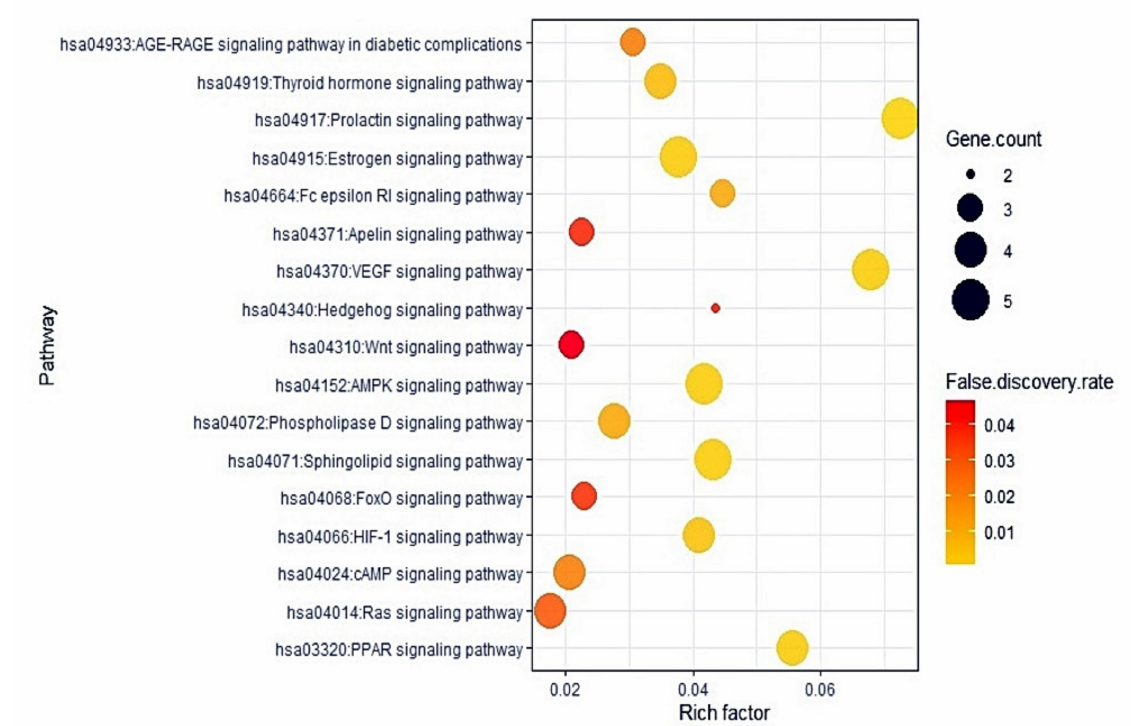
Figure 5. Bubble chart of 17 signaling pathways linked to the occurrence and progression of